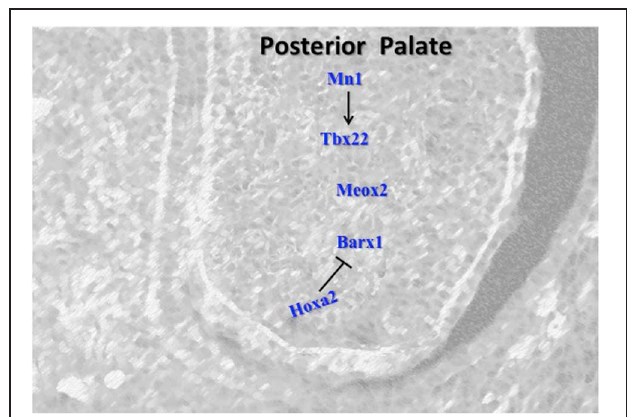
FIGURE 3 | Schematic representation of the key regulators in the posterior palate. Barx1 and Tbx22 induce cell proliferation in the posterior palate. Hoxa2 also controls the expression of Barx1 in the early stage of palatogenesis. Mn1 positively regulates Tbx22 and represents the first network determined to specifically regulate the level of proliferation in the posterior palate. Meox2 plays role in fusion of the posterior palate.